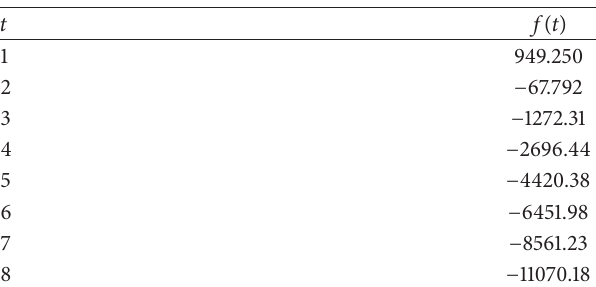
Table 3: The discrete function 𝑓(𝑡) in